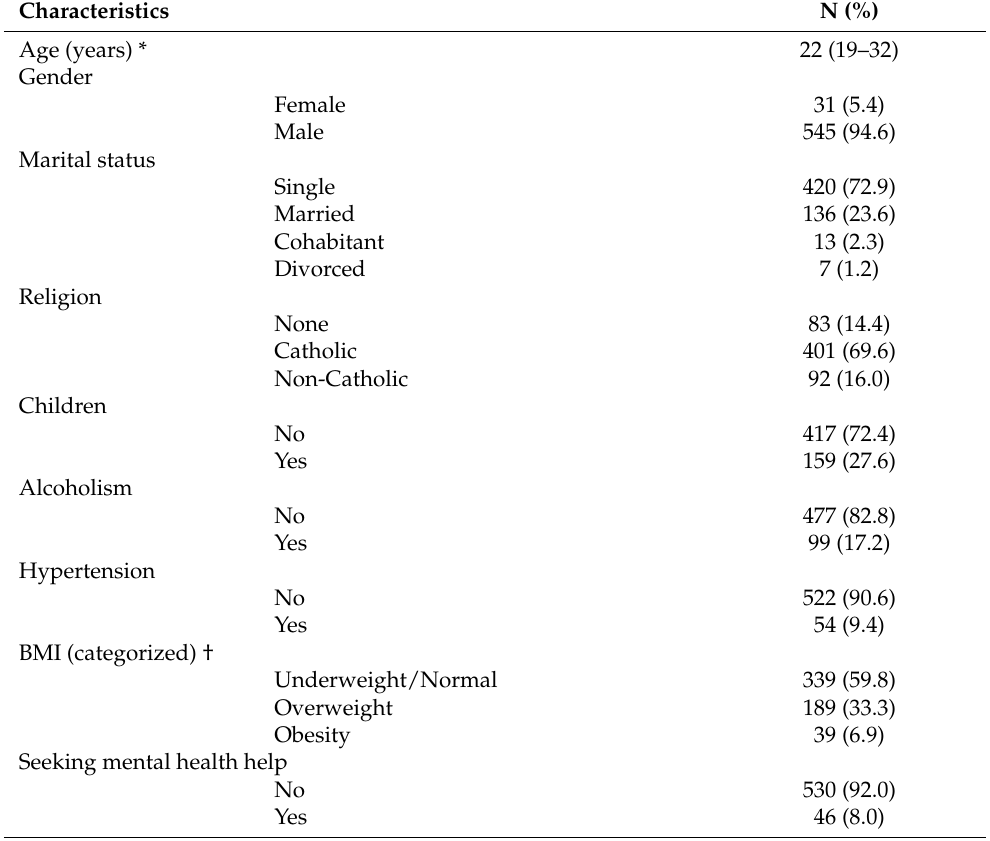
Table 1. Characteristics of